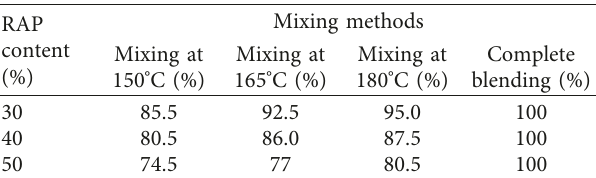
Figure 3: Prediction and measured dynamic different modulus master curve. Table 12: Different DOB under four mixing